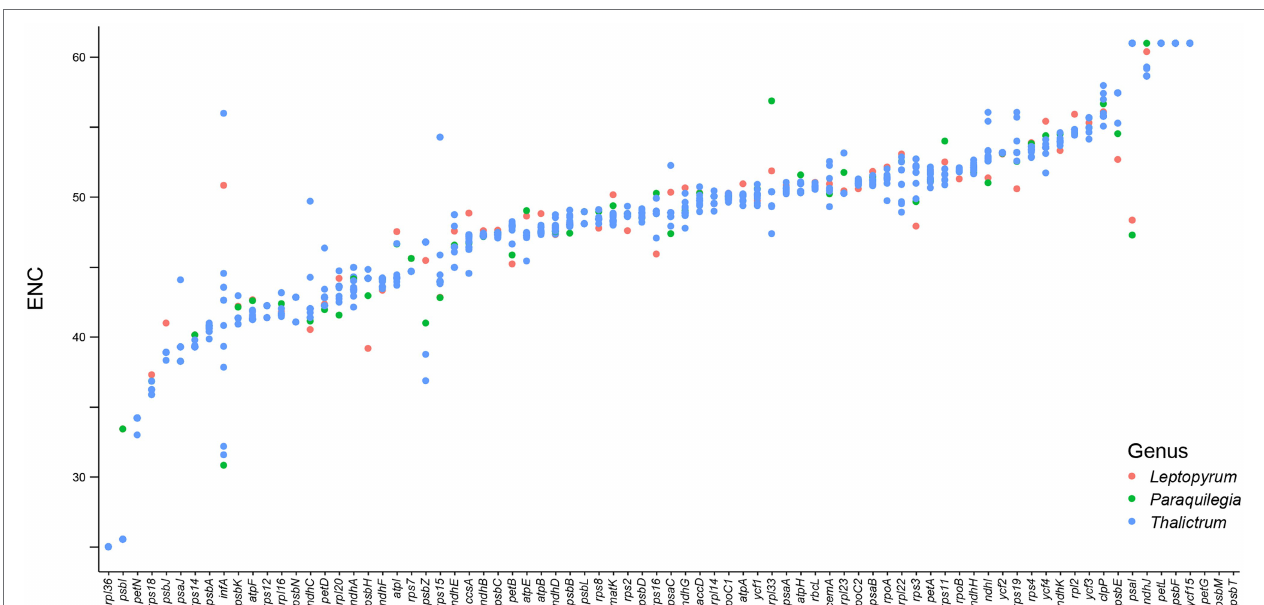
FIGURE 5 | The effective number of codons in the